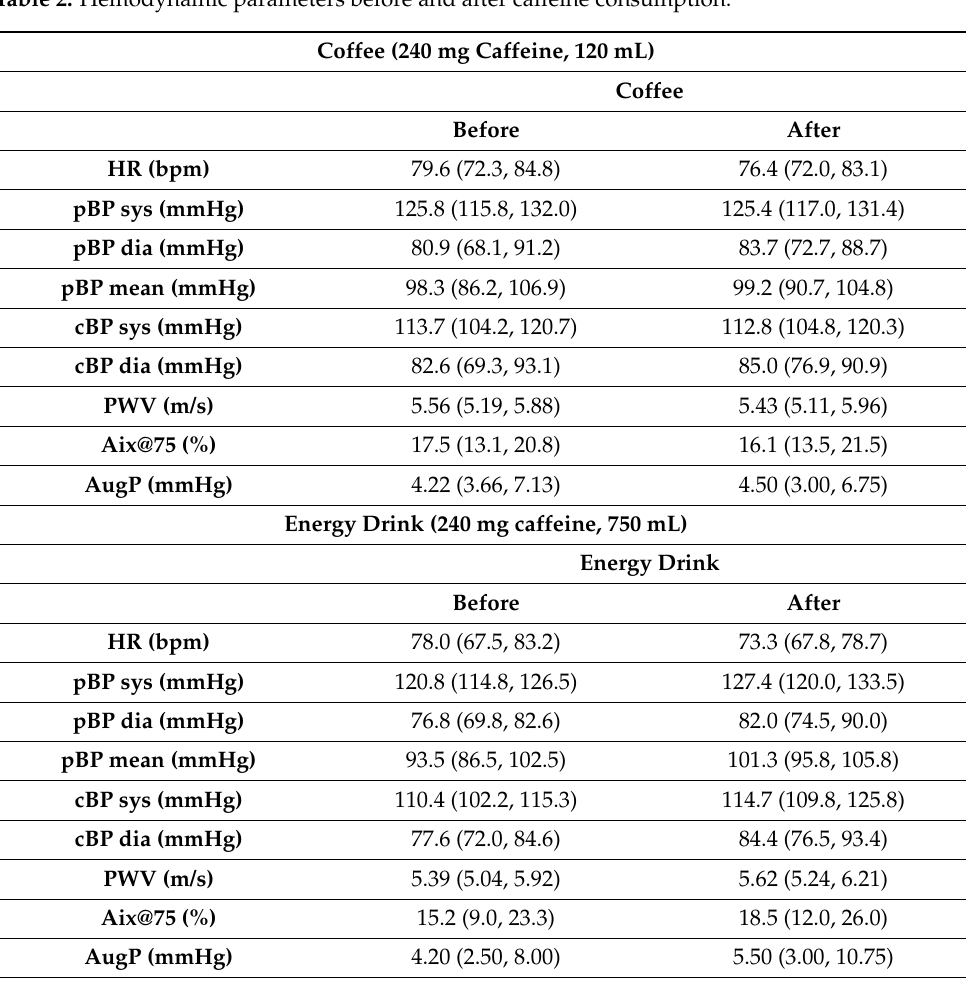
Table 2. Hemodynamic parameters before and after caffeine